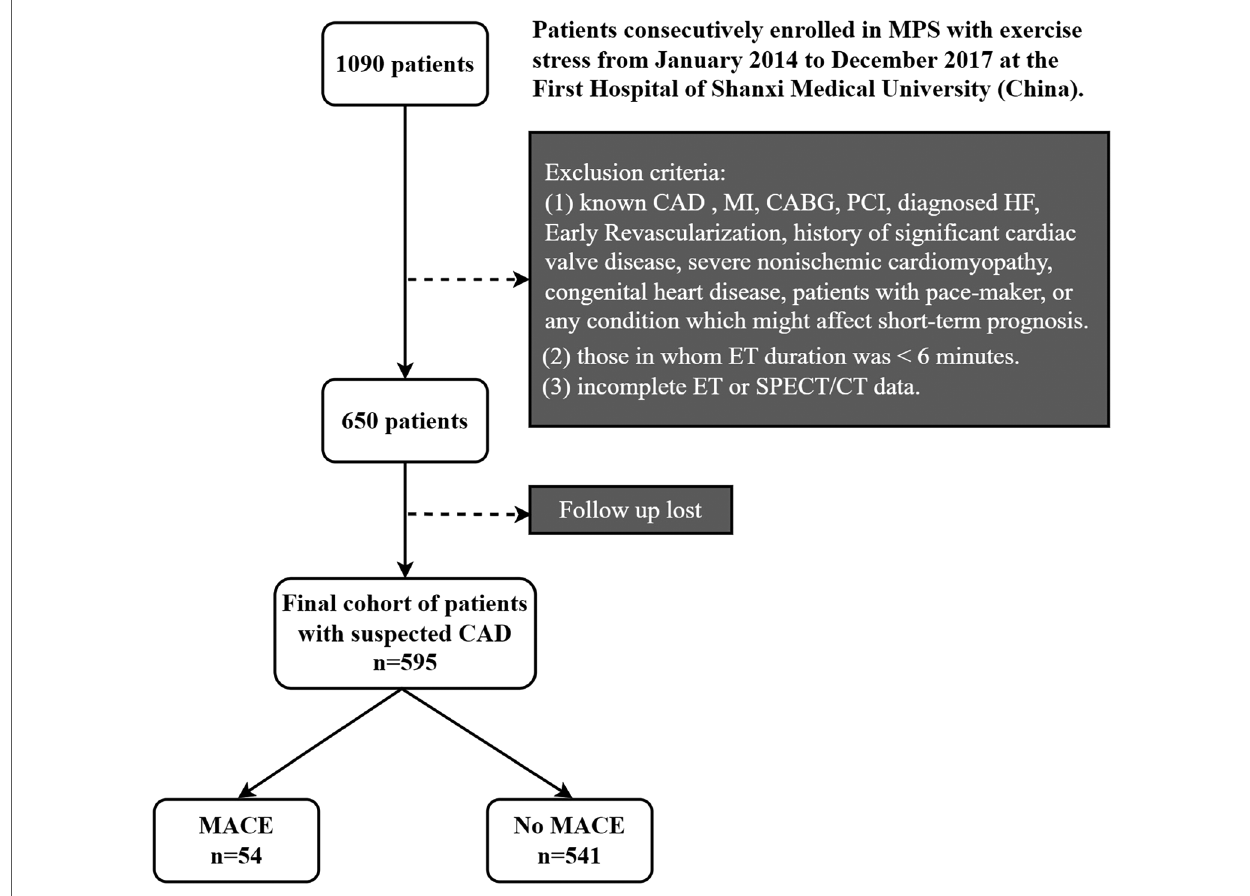
FIGURE 1 Flowchart of the study cohort. MPS, myocardial perfusion single-photon emission computed tomography; CAD, coronary artery disease; SPECT, single- photon emission computed tomography; ET, exercise test; MACE, major adverse cardiovascular events; MI, history of myocardial infarction; CABG; coronary artery bypass graft; PCI, percutaneous coronary intervention; HF, heart